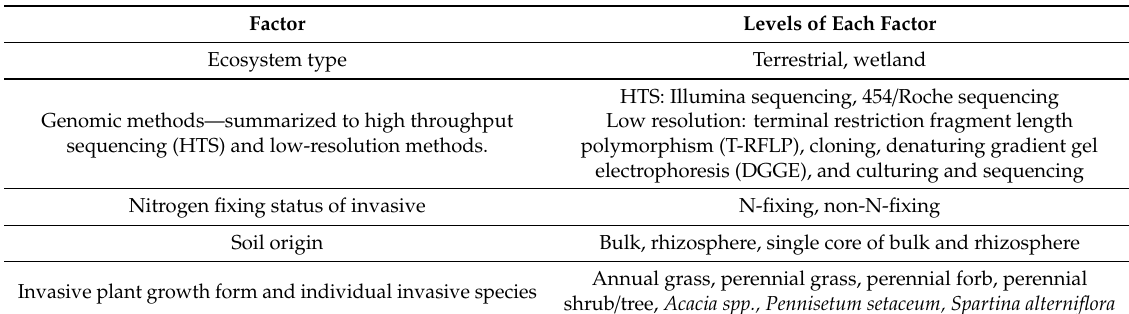
Table 1. Subgrouping factors and the possible levels for each factor used in the